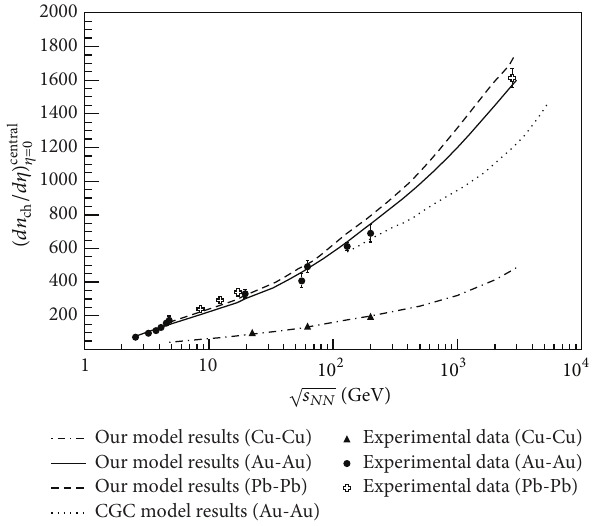
Figure 9: Variations of pseudorapidity density of charged hadrons at midrapidity as a function of √𝑠 𝑁𝑁 for different colliding nuclei along with the comparison of different model results [41,